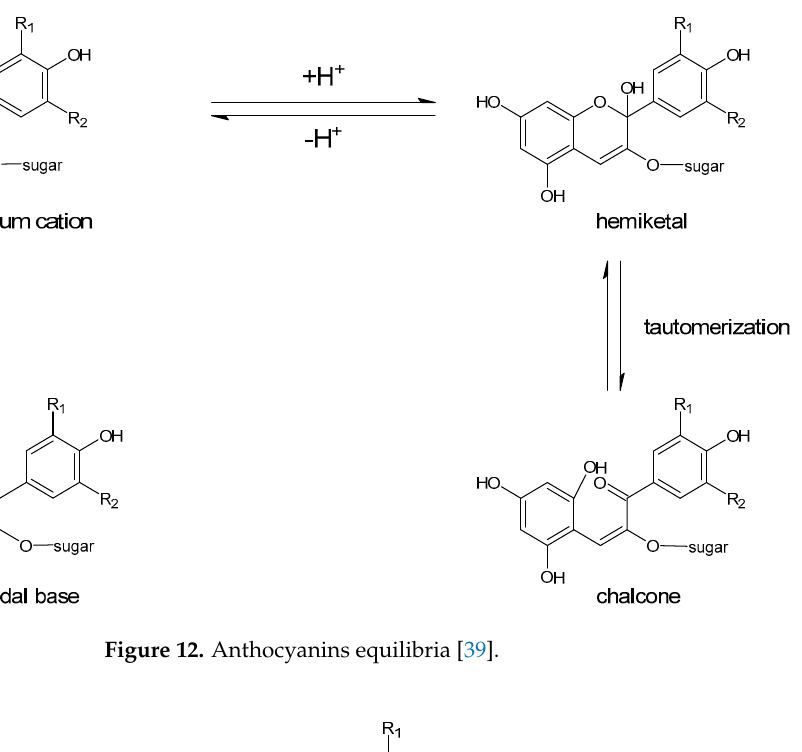
Figure 12. Anthocyanins equilibria [39].